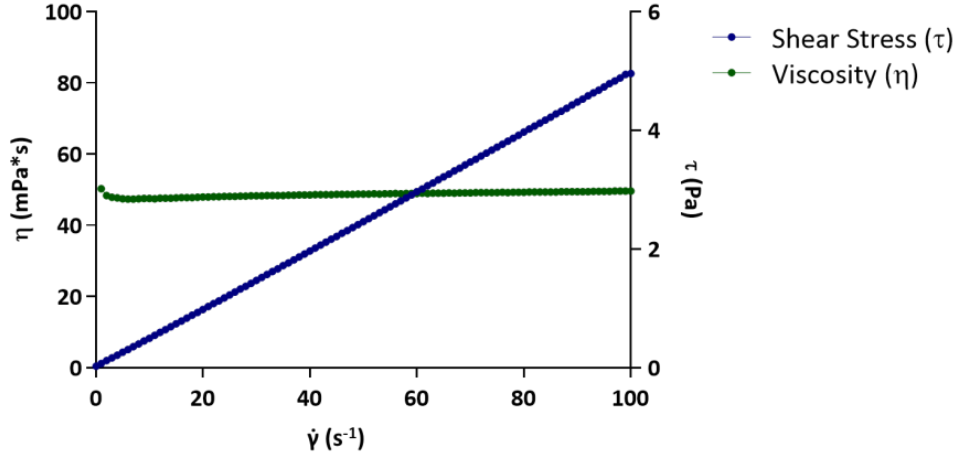
Figure 2. Newtonian flow of PAN-PMMA blend solution.